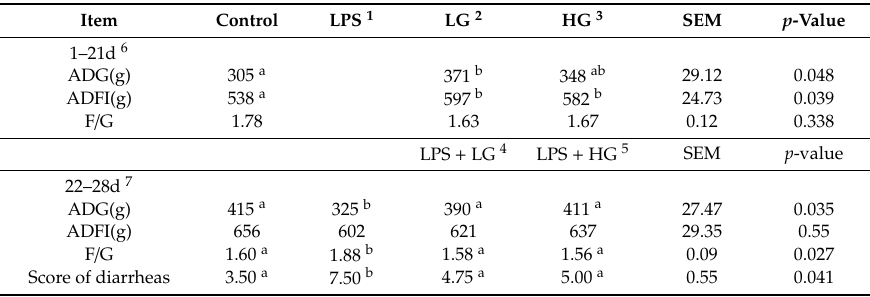
Table 5. Growth performance of piglets fed di ff erent molecular weight β -glucan.